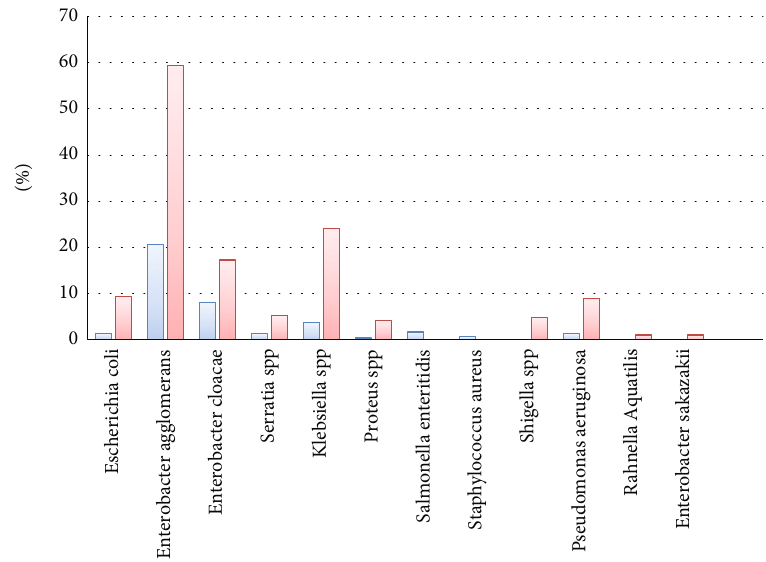
Figure 3: Bacterial organisms identi fi ed from shell surfaces of formal and informal eggs.